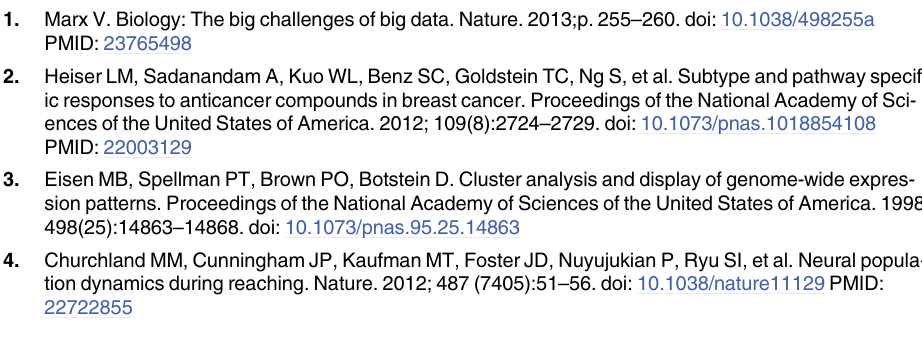
sparse corruption to X as shown in S2 Fig.) Left y -axis represents the norm of X − L and the right y -axis shows the rank of L . S2 Fig. The out of RPCA and RP-RPCA with two different λ values. (a) For λ = 0.113, both L rpca and L rp-rpca have rank 6 ( (cid:9) rank( X )) as shown in Fig 4(b). There is a big difference be- tween S rpca and the constructed corrupted signal ( X − X ) (b) For λ (cid:4) = 0.141, S rp-rpca is close corr but the low-rank components are misidentified by both RPCA and RP-RPCA be- to X − X corr cause both L rpca and L rp-rpca have rank 15. Therefore, for RP-RPCA, the separation of the low- rank component and sparse component is close to the true solution but for original RPCA, we have misidentification in both the low-rank and sparse components. We can easily see that S rpca shows characteristics of the low-rank component in S2 Fig. (middle columns of each panel). S3 Fig. Abstract HER2 overexpressed breast cancer model. Red arrow represents activation and blue dash bar represents inhibition. S4 Fig. Simple cluster analysis. (a) green solid line with circle represents y (= y + 0) and corr L (= x + x ) where filled circle represents corrupted blue solid line with circle represents x corr L S ) and unfilled square represents corruption data, unfilled circle represents uncorrupted data ( x L signal ( x ) (b) x - y plot with 1- correlation distance ( d ) without modification(left), with S corr corr xy disentanglement(middle), and with disentanglement/weighting factor γ .